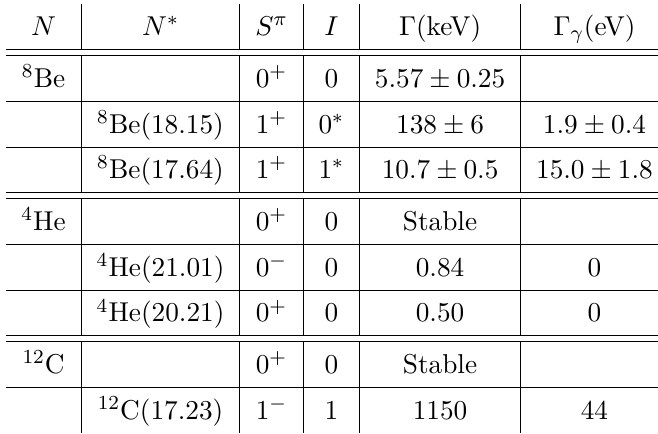
Table 1 . Spin-parity J π and isospin I quantum numbers, total decay widths Γ and γ -decay widths Γ = Γ( N ∗ → N γ ) for the nuclei used in the ATOMKI experiment: 8 Be [7], 4 He [8, 9] and γ 12 C [10, 11] nuclei. Asterisks on isospin assignments indicate states with significant isospin